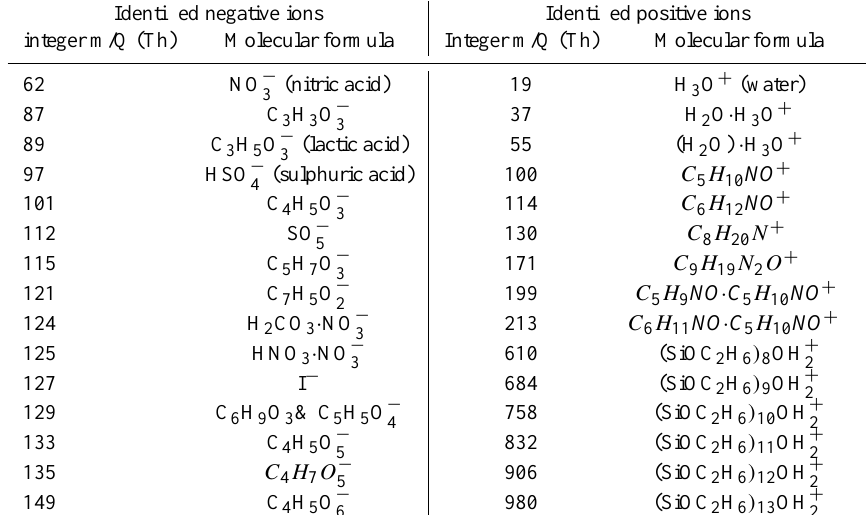
Table 1. Listing of some major negative and positive compounds in the ion spectra recorded using the APi-TOF. Names are given for the corresponding not deprotonated (negative ions) or protonated (positive ions) compounds. Molecular formulas in italics are not unambiguously identified.